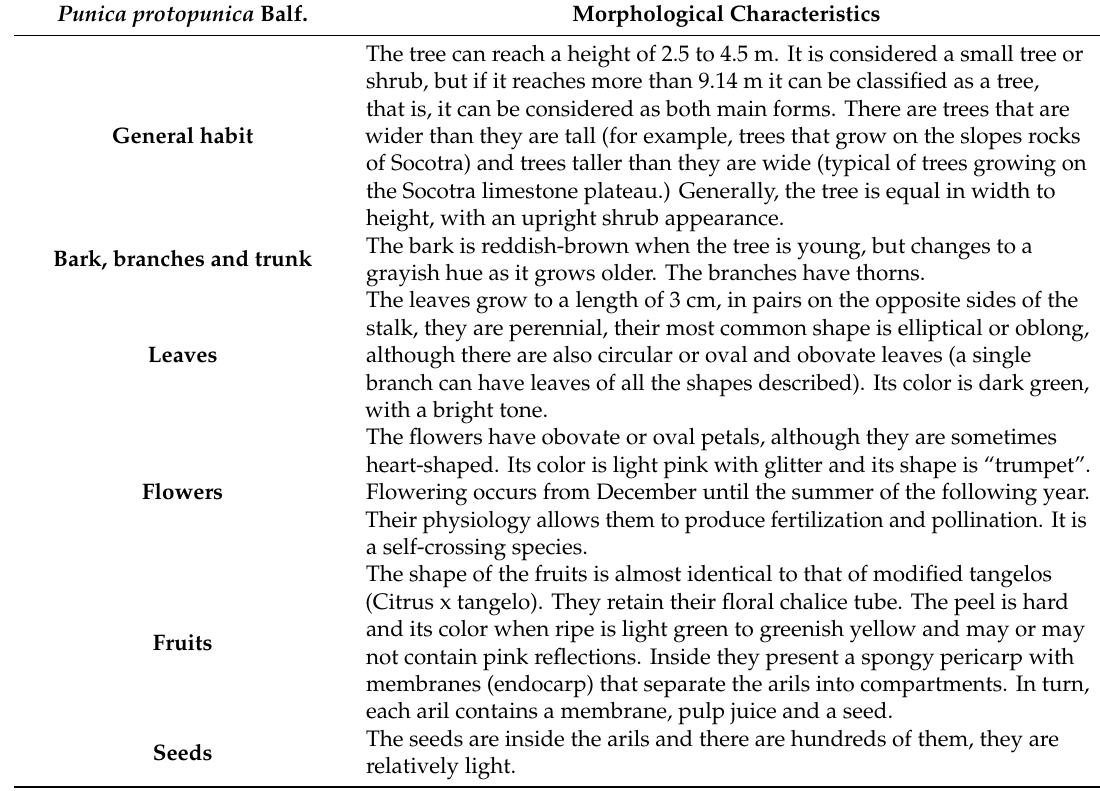
Table 2. Morphological characteristics of P. protopunica